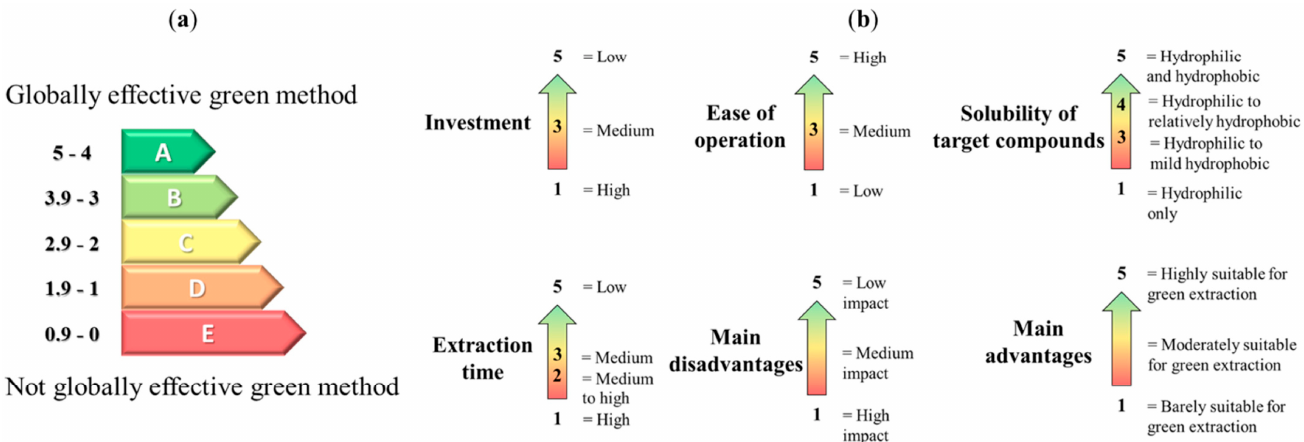
Figure 3. Caption of the rating index used for the different methods analysed ( a ) and for every criterion of each method ( b ). Table 3. Details about the rating given to every criterion of each method.